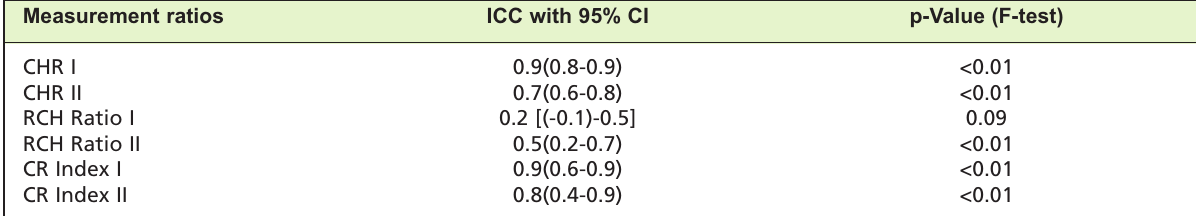
Inter-observer comparison of the measurements by intra-class correlation coefficient Table III: Measurement